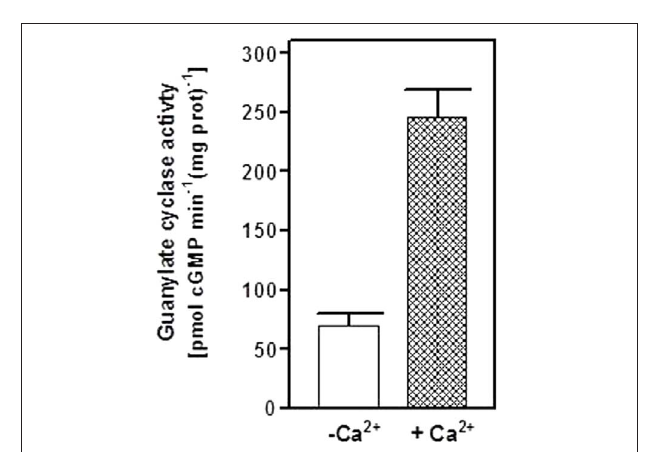
in the zona glomerulosa. (B) The immunostaining with the primary antibodies is specific. The mouse adrenal gland cryosections were processed identically as in (A) except that the primary antibody for ANF-RGC or neurocalcin δ was omitted in the respective incubation mixture but incubation with fluorescently labeled secondary antibody was carried out as in (A) . The DIC image showing the integrity of the sections are presented (“DIC”).